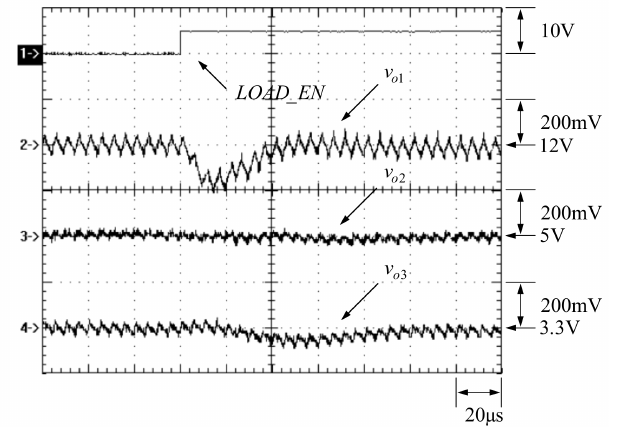
Figure 22. Dynamic response waveforms on condition that the main output load is changed from light load to rated load as the first and second secondary outputs are located at light load.